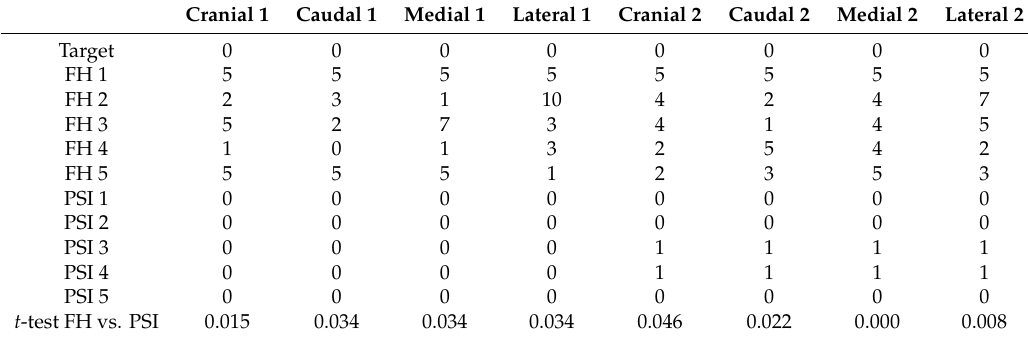
t ‐ test FH vs. PSI